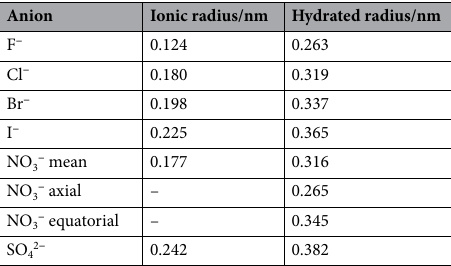
Table 2. Summary of ionic and hydrated radii of anions tested in this study. Data taken from 37